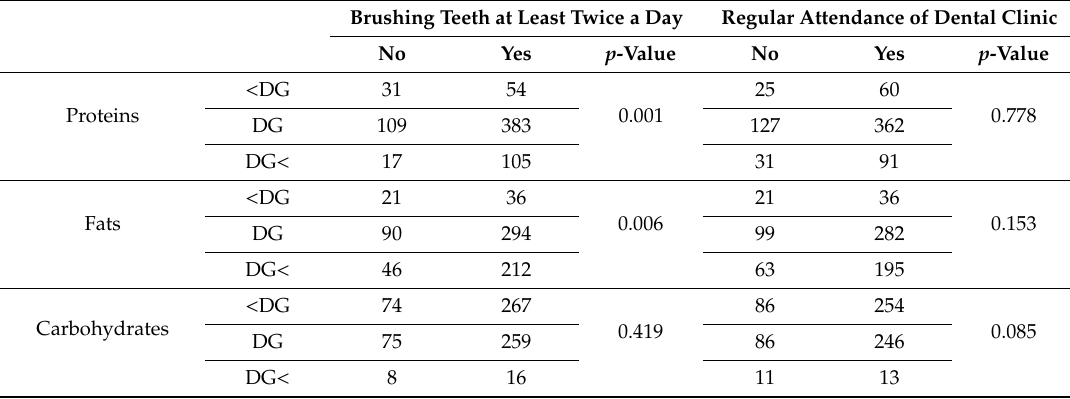
Table 3. Oral health behavior and three macronutrients